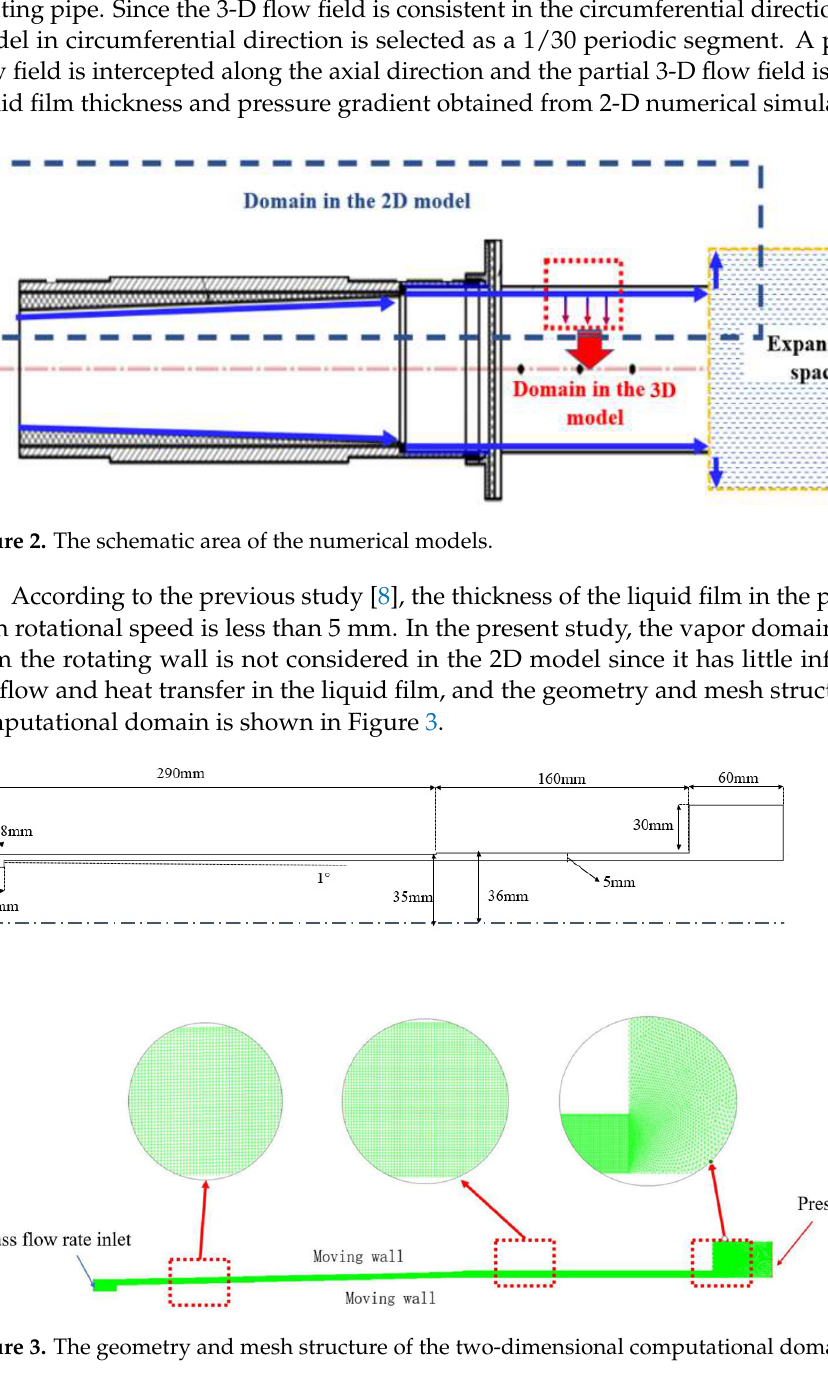
Figure 3. The geometry and mesh structure of the two-dimensional computational domain.